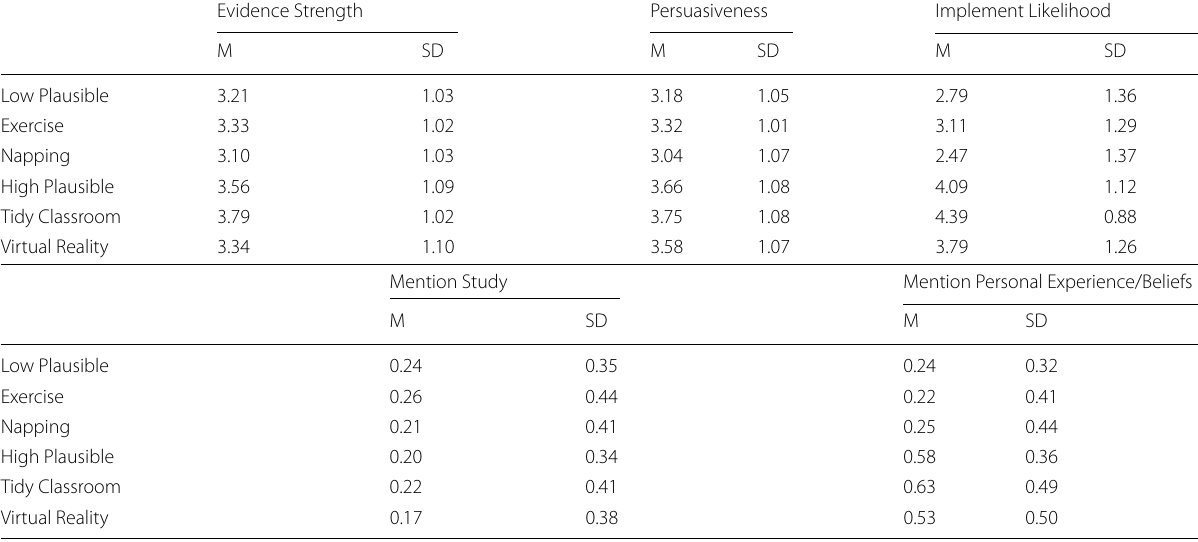
Table 5 Descriptive statistics for article ratings and open-ended responses for Experiment 2 Evidence Strength Persuasiveness Implement